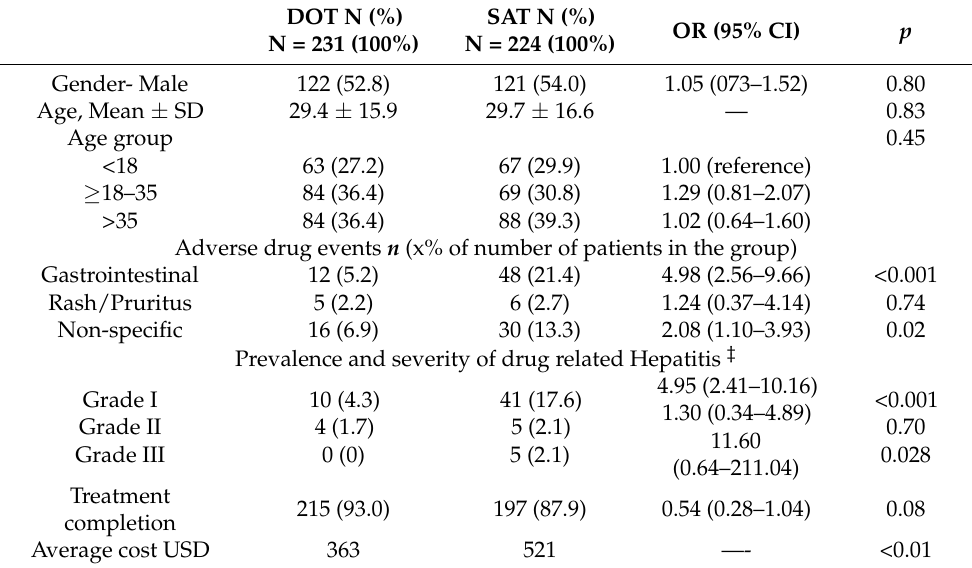
Table 1. Demographic characteristics and outcome measures of latent TB treatments among Ethiopian Immigrants in Israel.